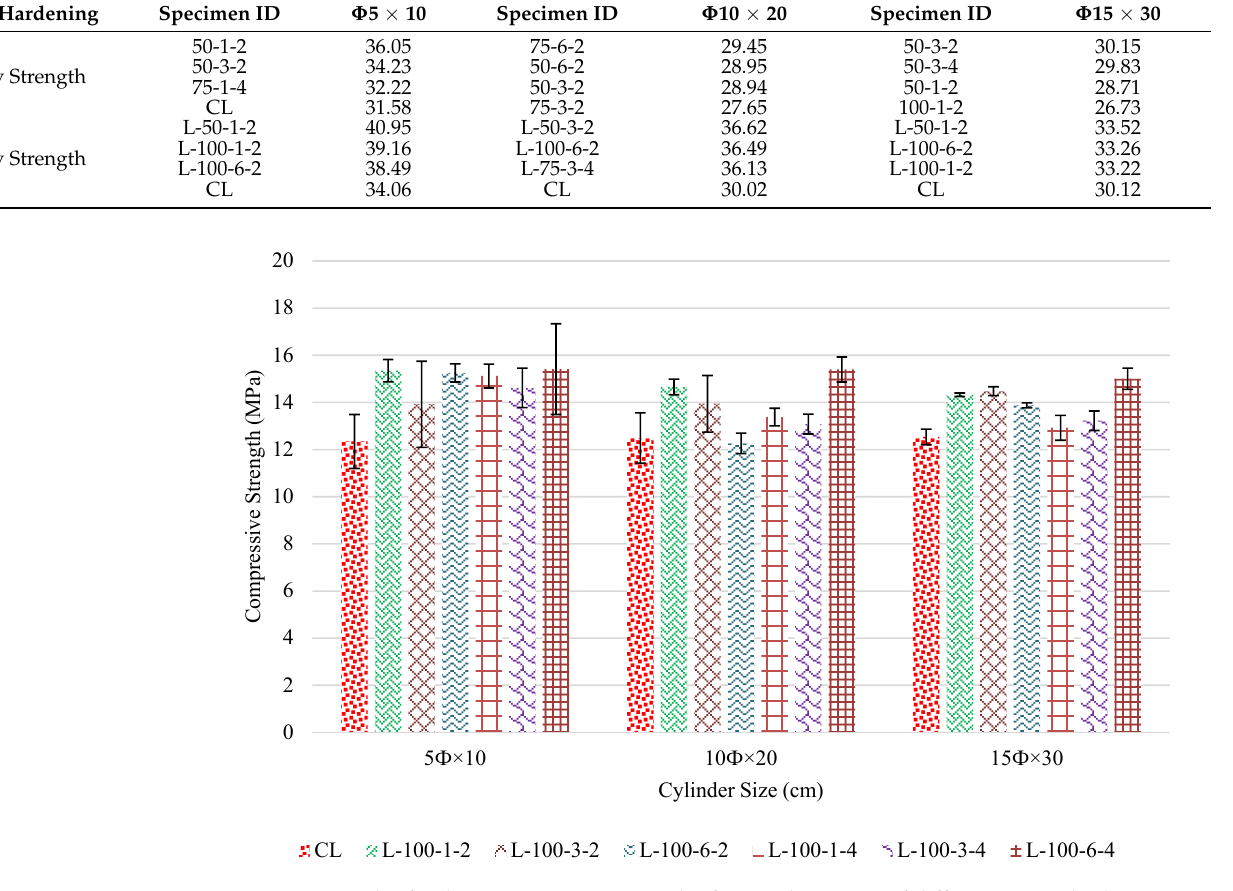
Figure 2. Result of 3-day compressive strength of normal concrete of different size cylinders.